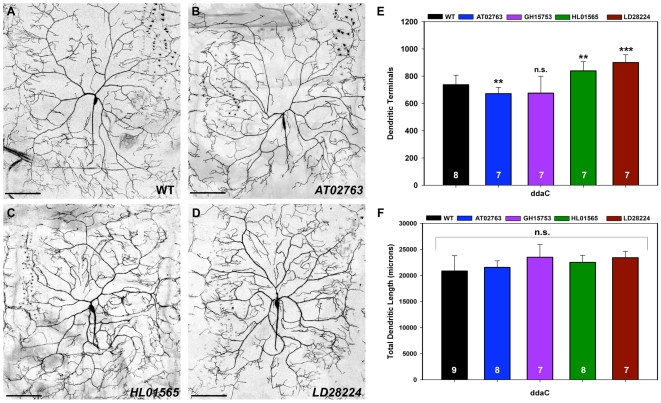
Isoform-specific Tutl overexpression differentially effects dendrite branching in class IV da neurons.(A–D) Representative live confocal images of wild-type and Tutl isoform overexpressing class IV ddaC neurons collected at 20X magnification. Anterior is left and dorsal up and size bar represents 100 microns. (A) Wild-type (WT) class IV ddaC neuron. (B) Overexpression of the non-membrane bound Tutl AT02763 isoform reduces dendritic branching in ddaC neurons particularly at dendritic terminals. (C,D) Overexpression of the membrane bound Tutl HL01565 (C) and Tutl LD28224 (D) isoforms increases dendritic branching in ddaC neurons most evident at dendritic terminals. (E) Quantification of ddaC dendritic branch termini revealed a statistically significant decrease with AT02763 overexpression and increase with both HL01565 and LD28224 overexpression relative to wild-type controls. (F) Quantification of ddaC total dendritic length revealed no statistically significant (n.s, p>0.05) change with Tutl isoform overexpression relative to wild-type controls. The total n value for each genotype quantified is reported on the bar graphs. Statistically significant p values are reported on the graph as follows (** = p<0.01; *** = p<0.001; n.s. = not significant). Genotypes (A–D): WT: GAL4477,UASmCD8::GFP/+; AT02763: UAS-tutlAT02763/+; GAL4477,UASmCD8::GFP/+; GH15753: UAS-tutlGH15753/+; GAL4477,UASmCD8::GFP/+; HL01565: GAL4477,UASmCD8::GFP/+; UAS-tutlHL01565/+; LD28224: GAL4477,UASmCD8::GFP/+; UAS-tutlLD28224/+.